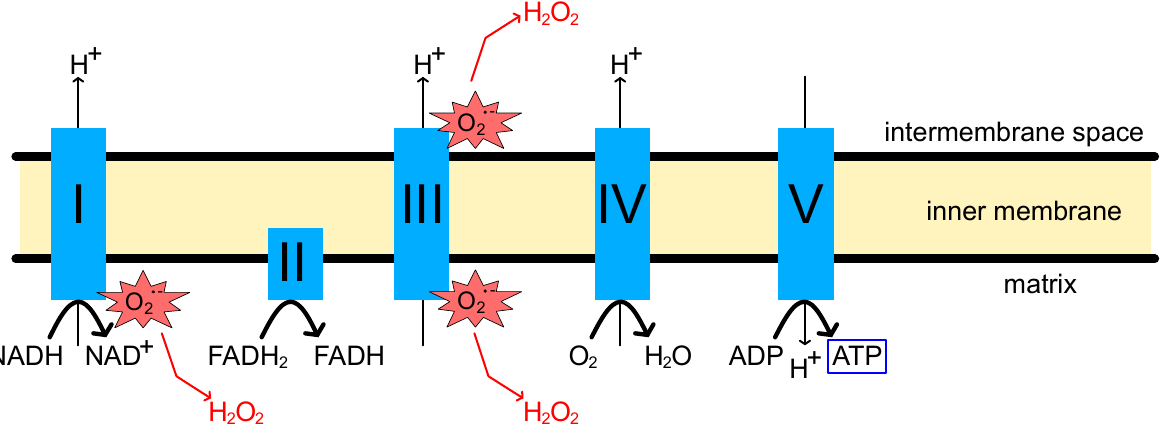
Figure 2. Schematic image of oxidative phosphorylation (OXPHOS) process and reactive oxygen species (ROS) production.